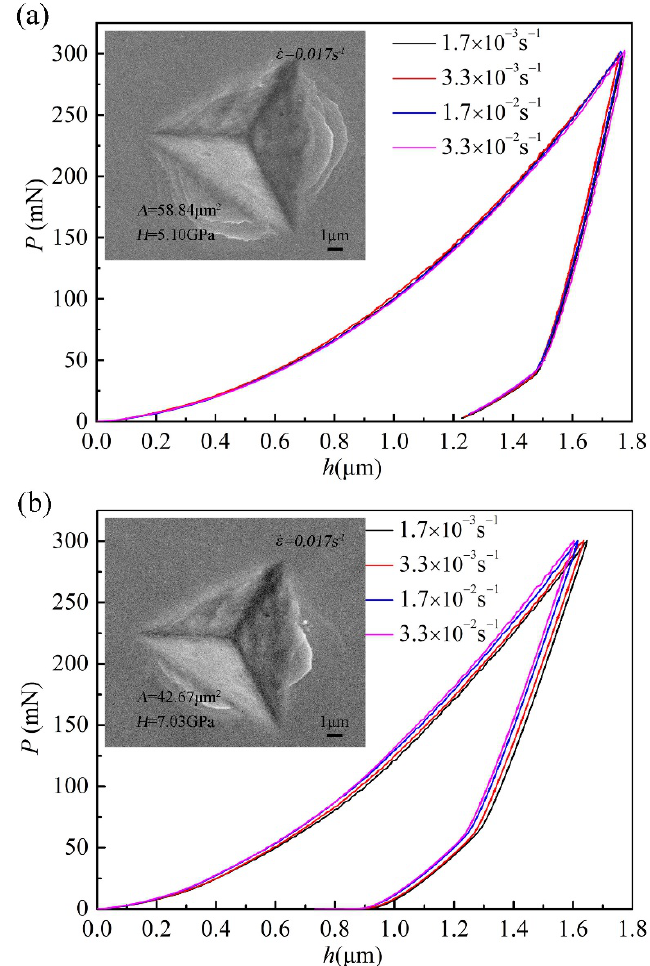
Figure 3. Representative P-h curves under di ff erent equivalent strain rates but a fixed peak load of 300 mN for ( a ) as-cast and ( b ) 650 K–30 min annealed, the insets show the SEM micrographs of nanoindentation tested at the equivalent strain rate of 0.017 s − 1 .